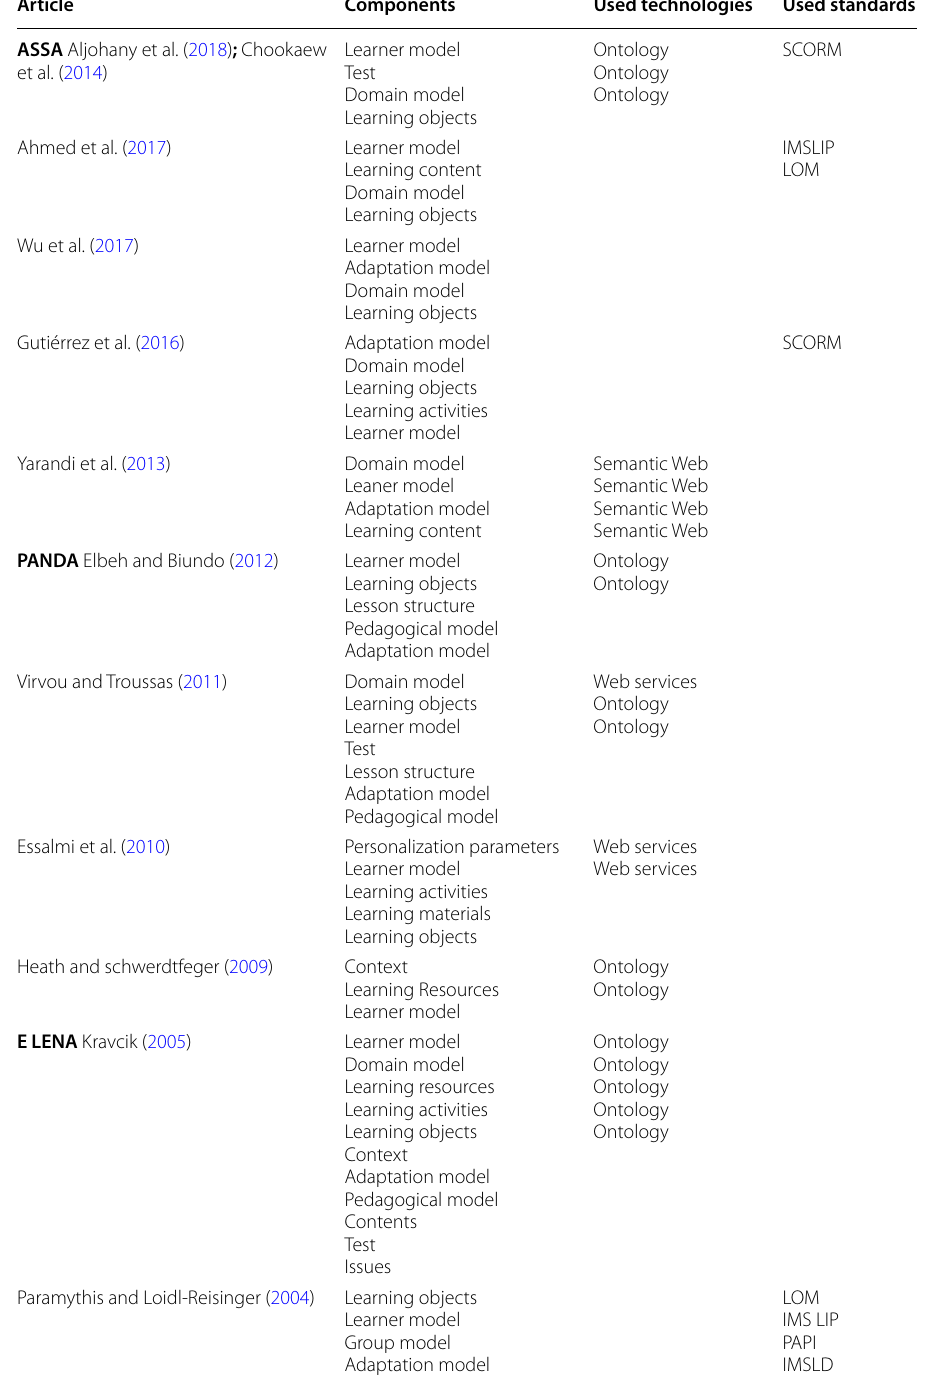
Table 1 Learning components Article Components Used